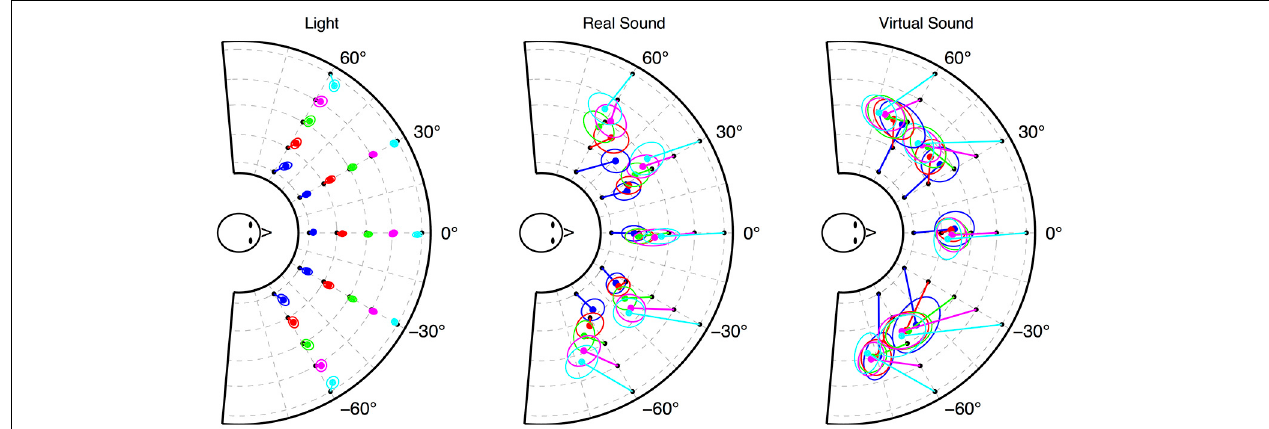
FIGURE 3 | Mean of all subjects’ reported location with 50% confidence ellipse linked to source location for each rendering condition: visual (left), real sound (center), and virtual sound (right).